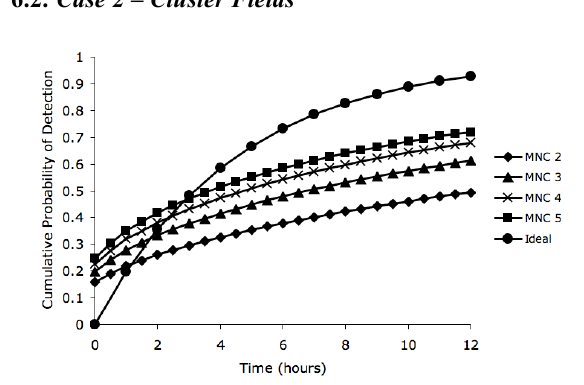
Fig.15. Average CPD of Initial USDEA Cluster Fields Communications Range = 5.5 kyd